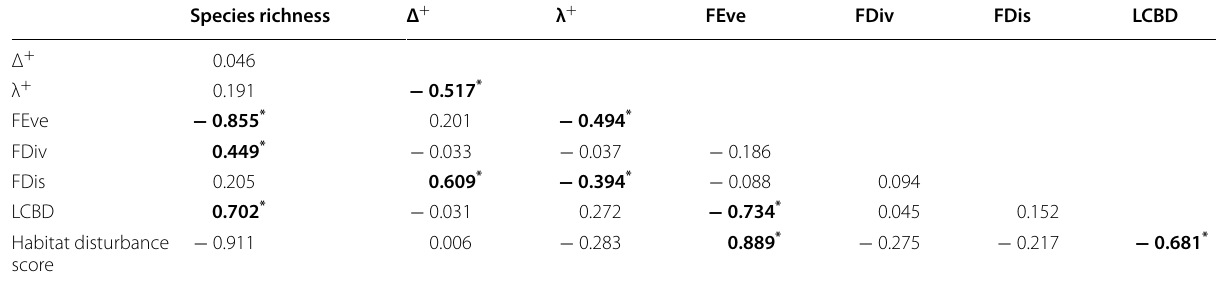
Significant ( p < 0.05) values are indicated by boldface and * mark